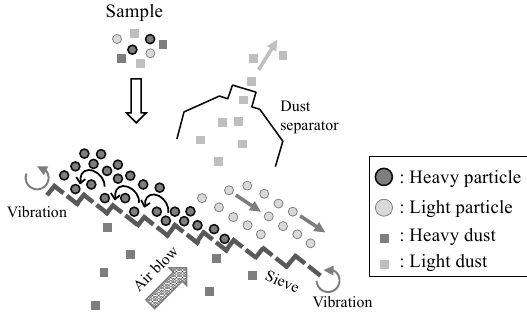
Figure 1. Mechanism of dry gravity classification.